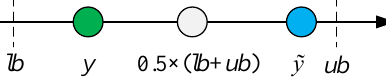
Figure 1. Opposite pair inside [ lb , ub ]